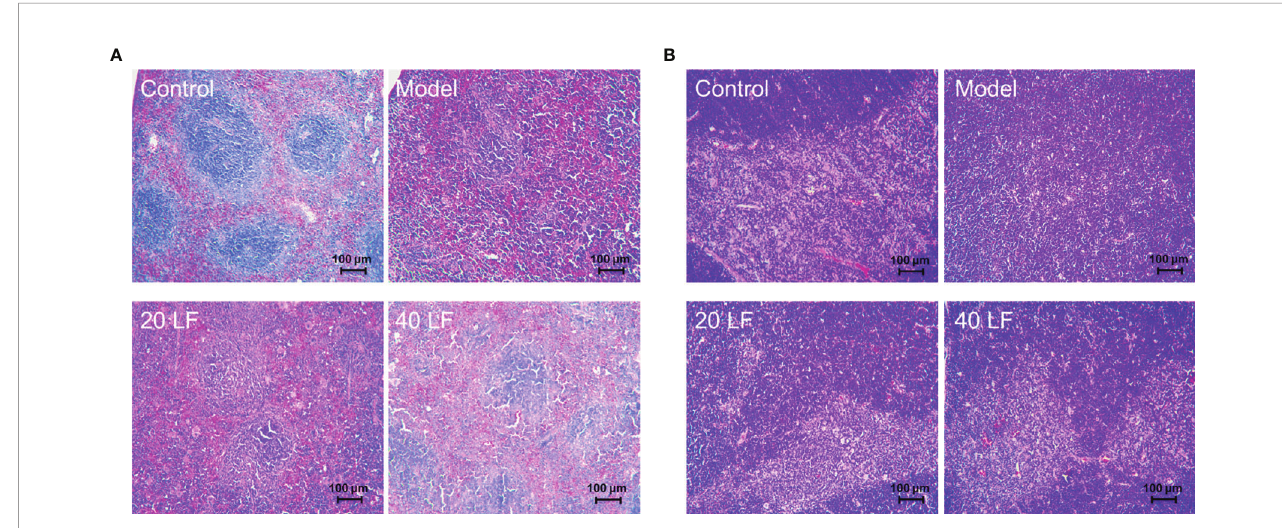
FIGURE 3 | Histomorphology of spleen (A) and thymus (B) in mice